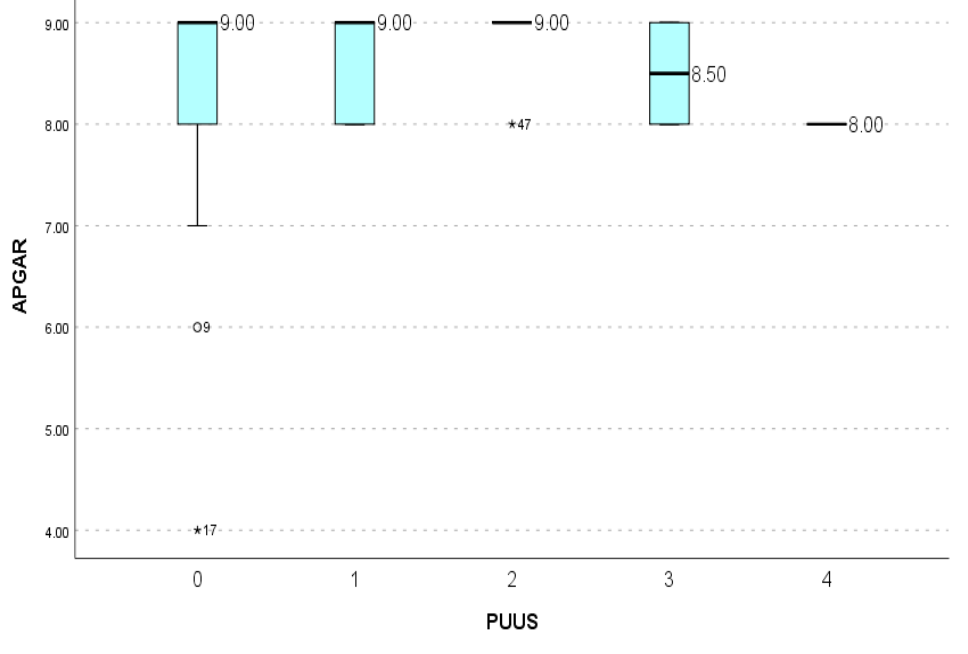
Figure 8. PUUS grades did not vary significantly with the Apgar scores of the neonate. * represents extreme outliers, data that markedly differ from other observations.